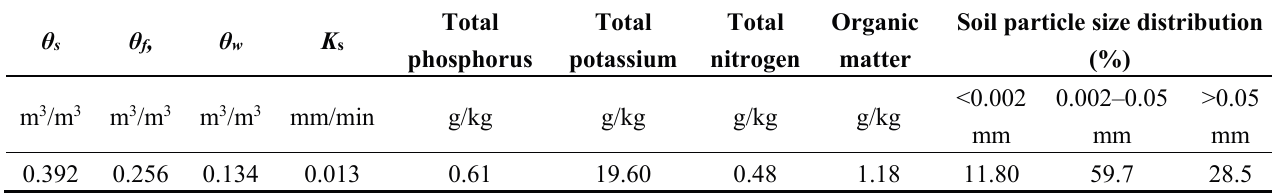
Table 2. Physical and chemical properties of tested